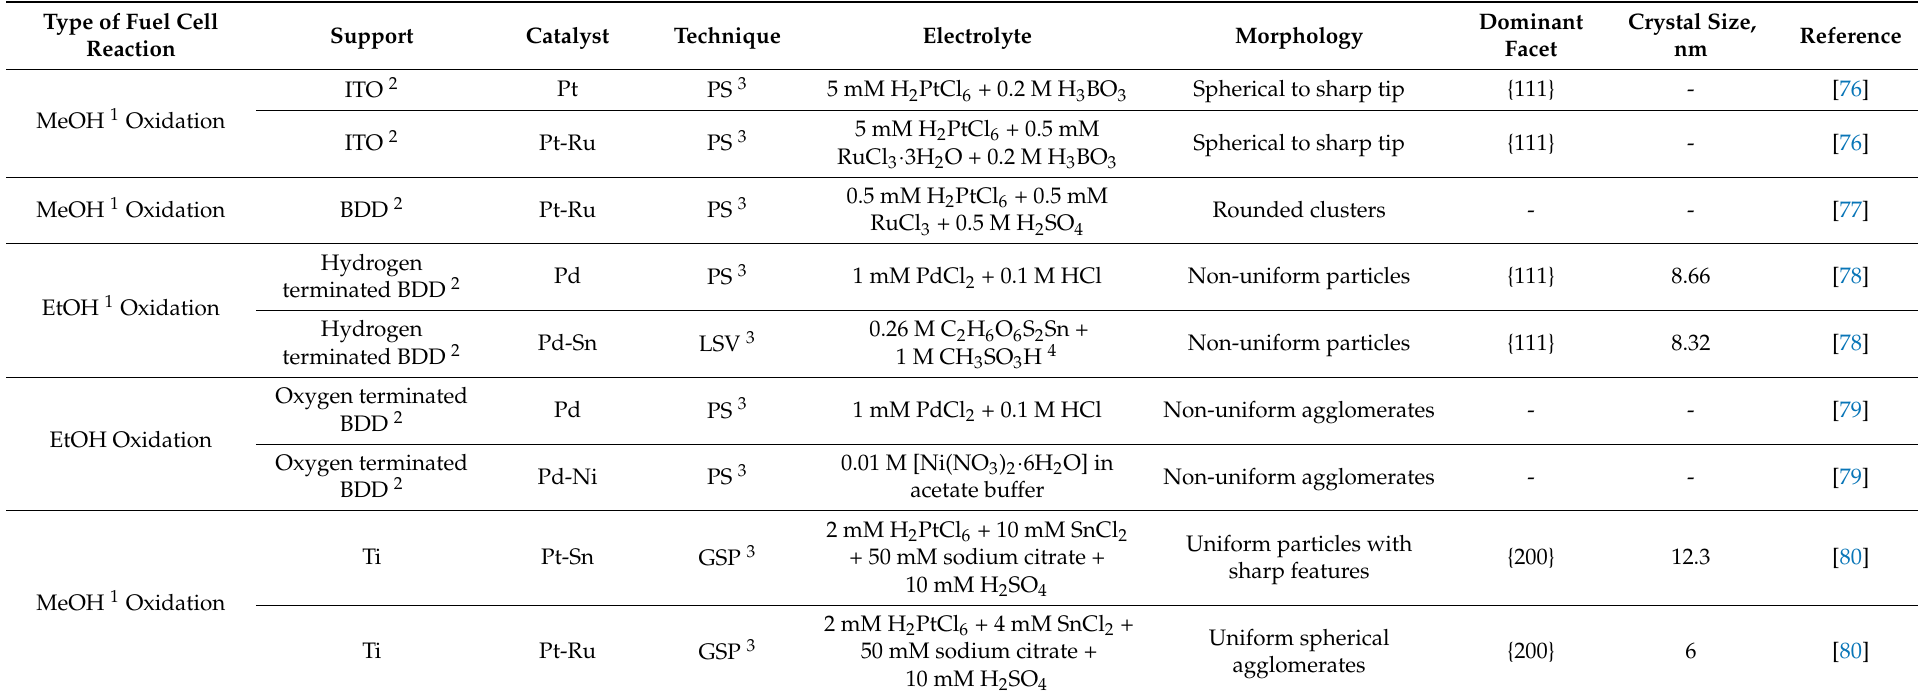
Table 3. Work reported on the electrodeposition of Pt and Pd on non-carbon